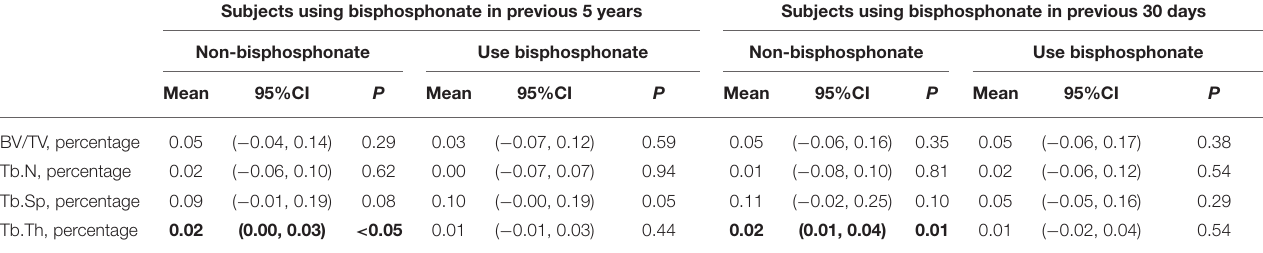
TABLE 3 | Yearly change of subchondral bone morphometry.